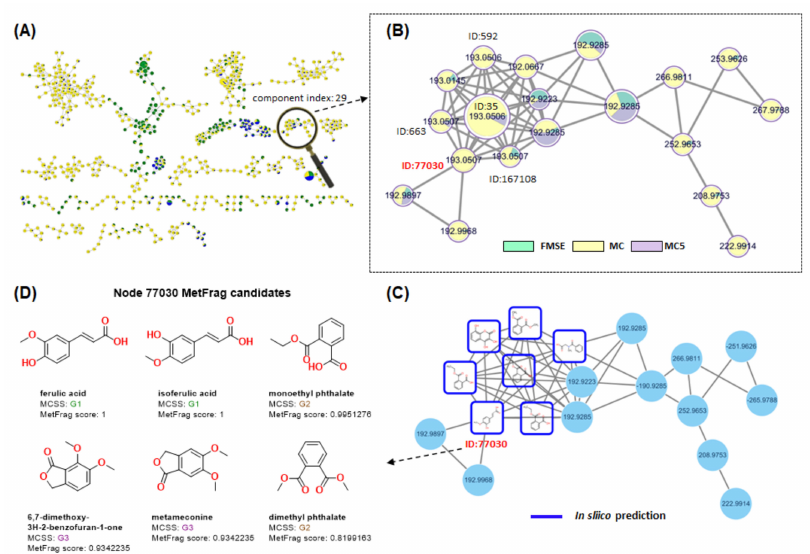
Figure 5. Feature-based molecular networking and NAP analysis of FMSE extract, MC, and MC5 fractions. ( A ) Molecular network of all the detected features (three or more connected nodes of a graph). ( B ) Expanded for component index 29 in the molecular network. Feature IDs were indicated for m/z = 193.0506 or 193.0507 [M-H] − of precursor ions. ( C ) NAP result of component index 29, in silico prediction (blue squared). ( D ) Structures of top ranked NAP candidates for node 77030 by MCSS-based